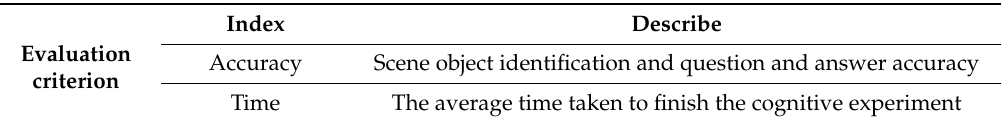
Table 3. Evaluation criterion.